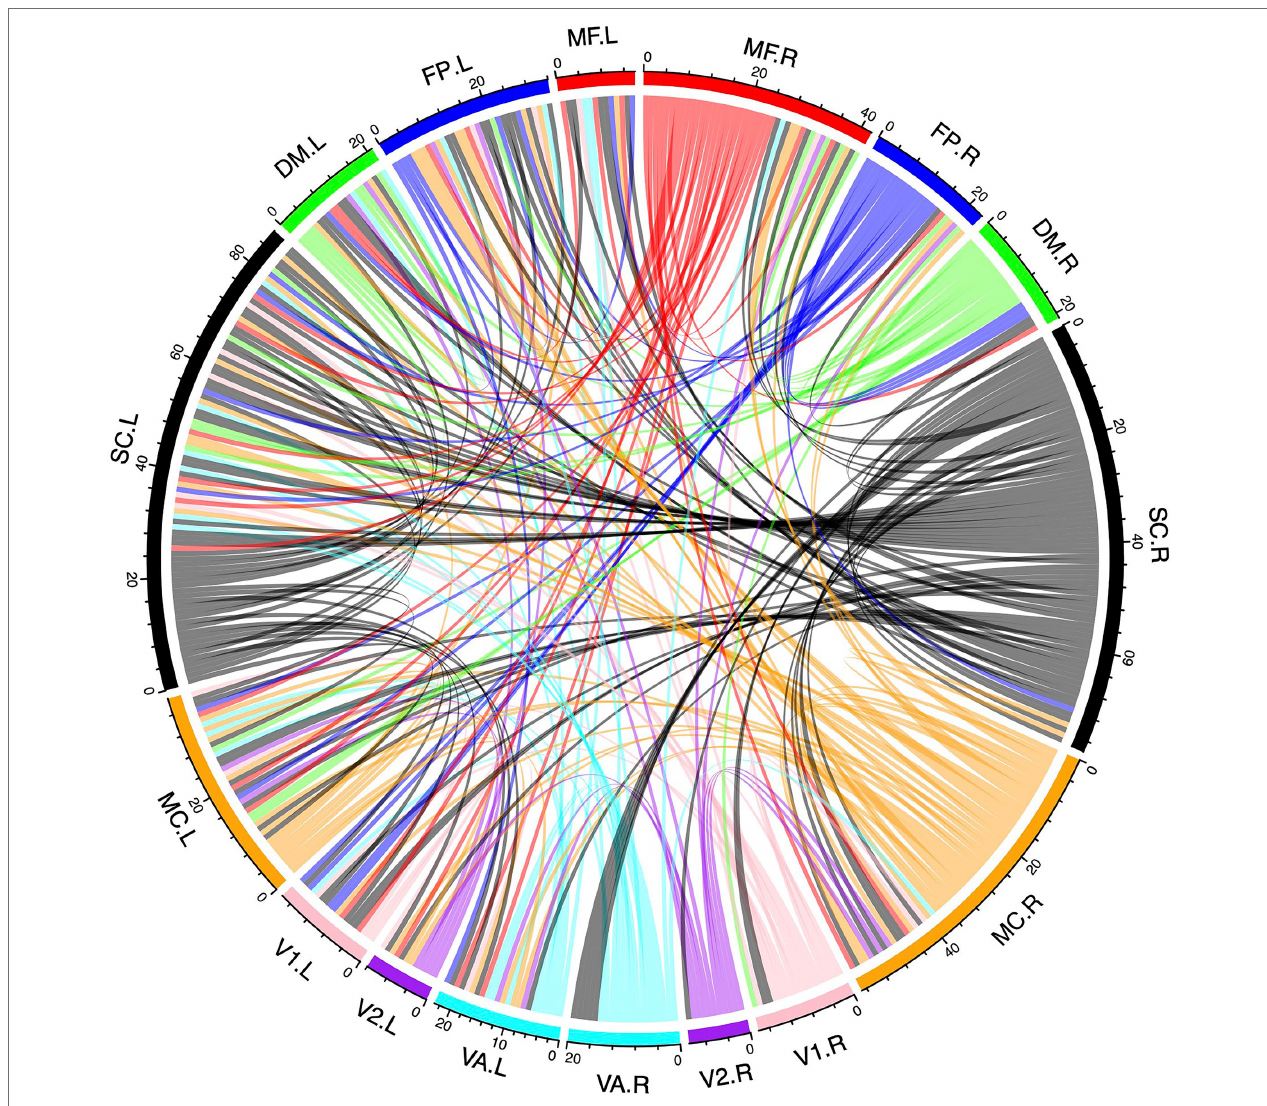
FIGURE 7 | Predictive patterns of phase synchrony for inattention. MF stands for the medial frontal network. FP represents the frontoparietal network. DM means the default mode network. SC denotes the subcortical-cerebellum network. MC represents the motor cortex network. V1 denotes the visual I network. V2 denotes the visual II network. VA stands for the visual association